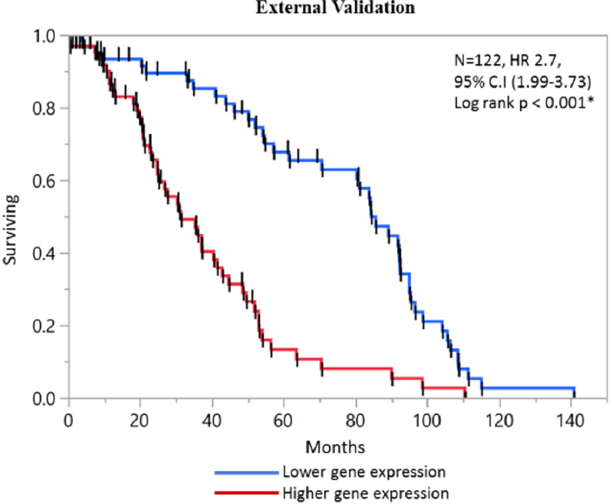
Figure 4. The external validation using independent dataset validated the four gene prognostic score.